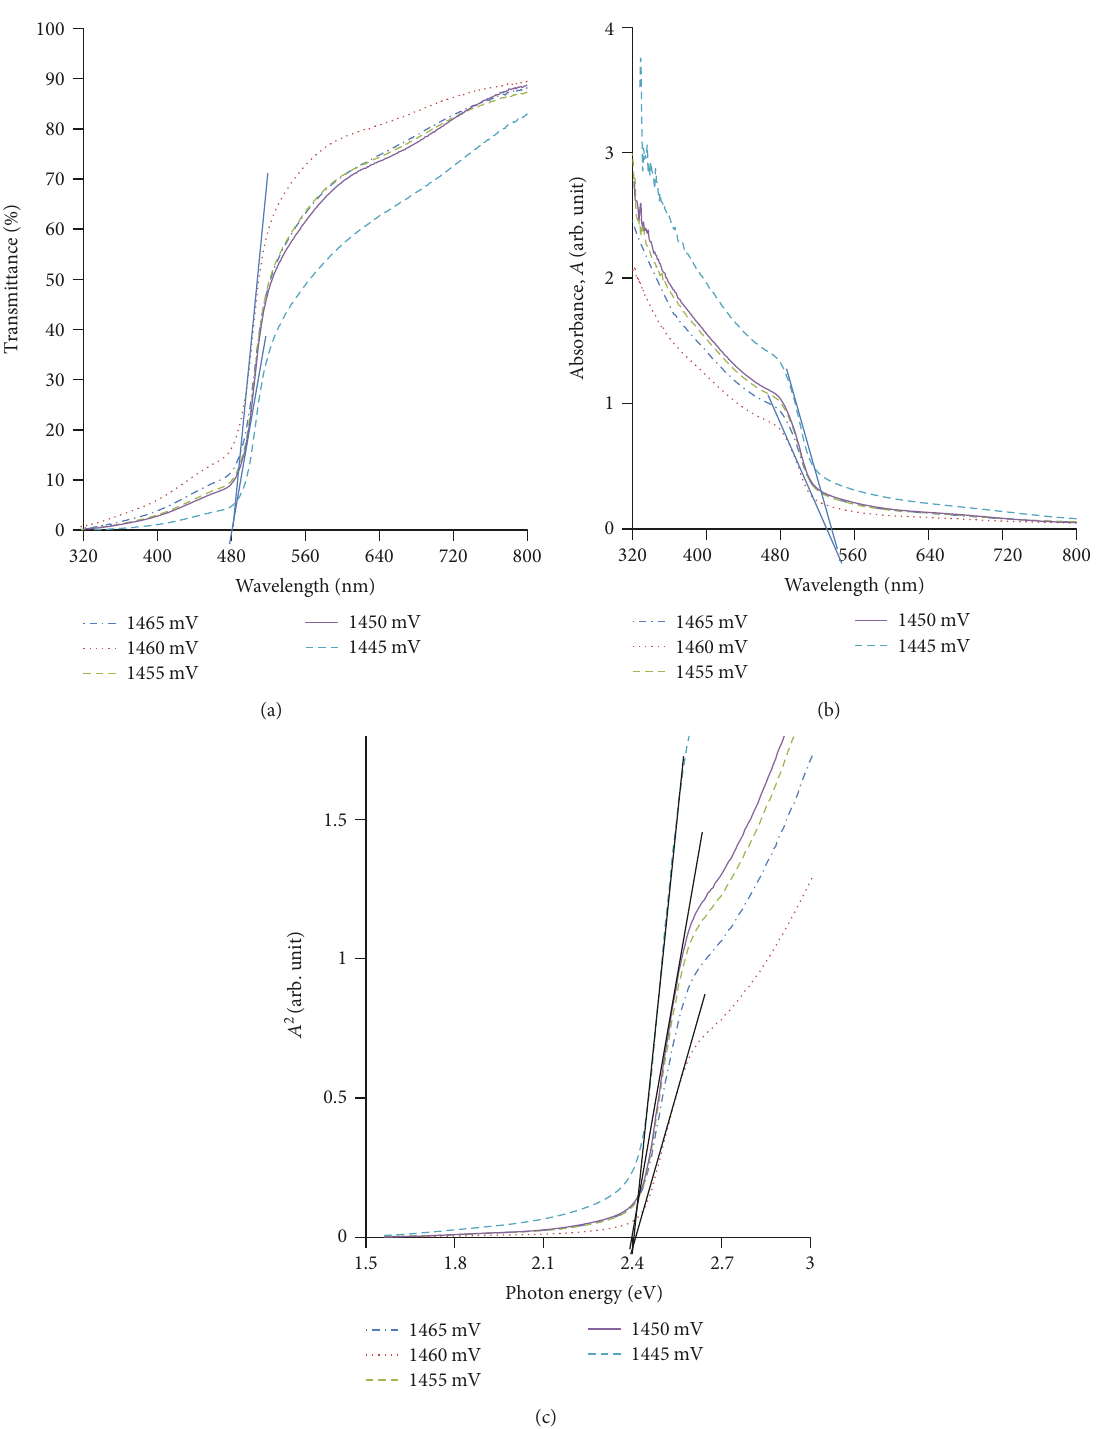
Figure 4: (a) Transmittance versus wavelength, (b) absorbance ( A ) versus wavelength, and (c) A 2 versus photon energy for annealed CdS samples grown at di ff erent cathodic voltages for 45